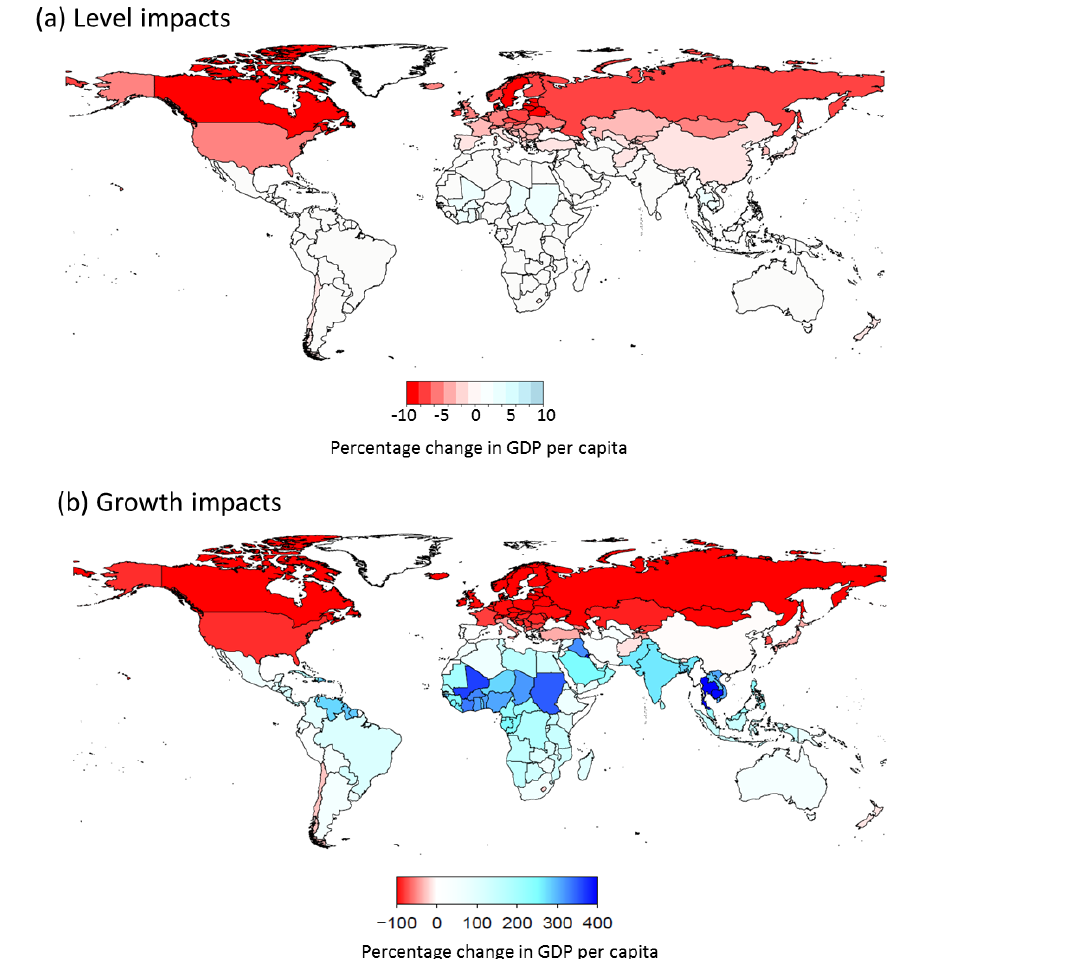
Figure 4. Projected impacts of a 4 ◦ C global cooling on country GDP per capita in 2100. Changes are relative to projections without climate change according to SSP5. (a) Changes according to NPS specification (GDP level effects); (b) changes according to BHM specification (GDP growth effects). NB: color scales have different maximum and minimum values for easier